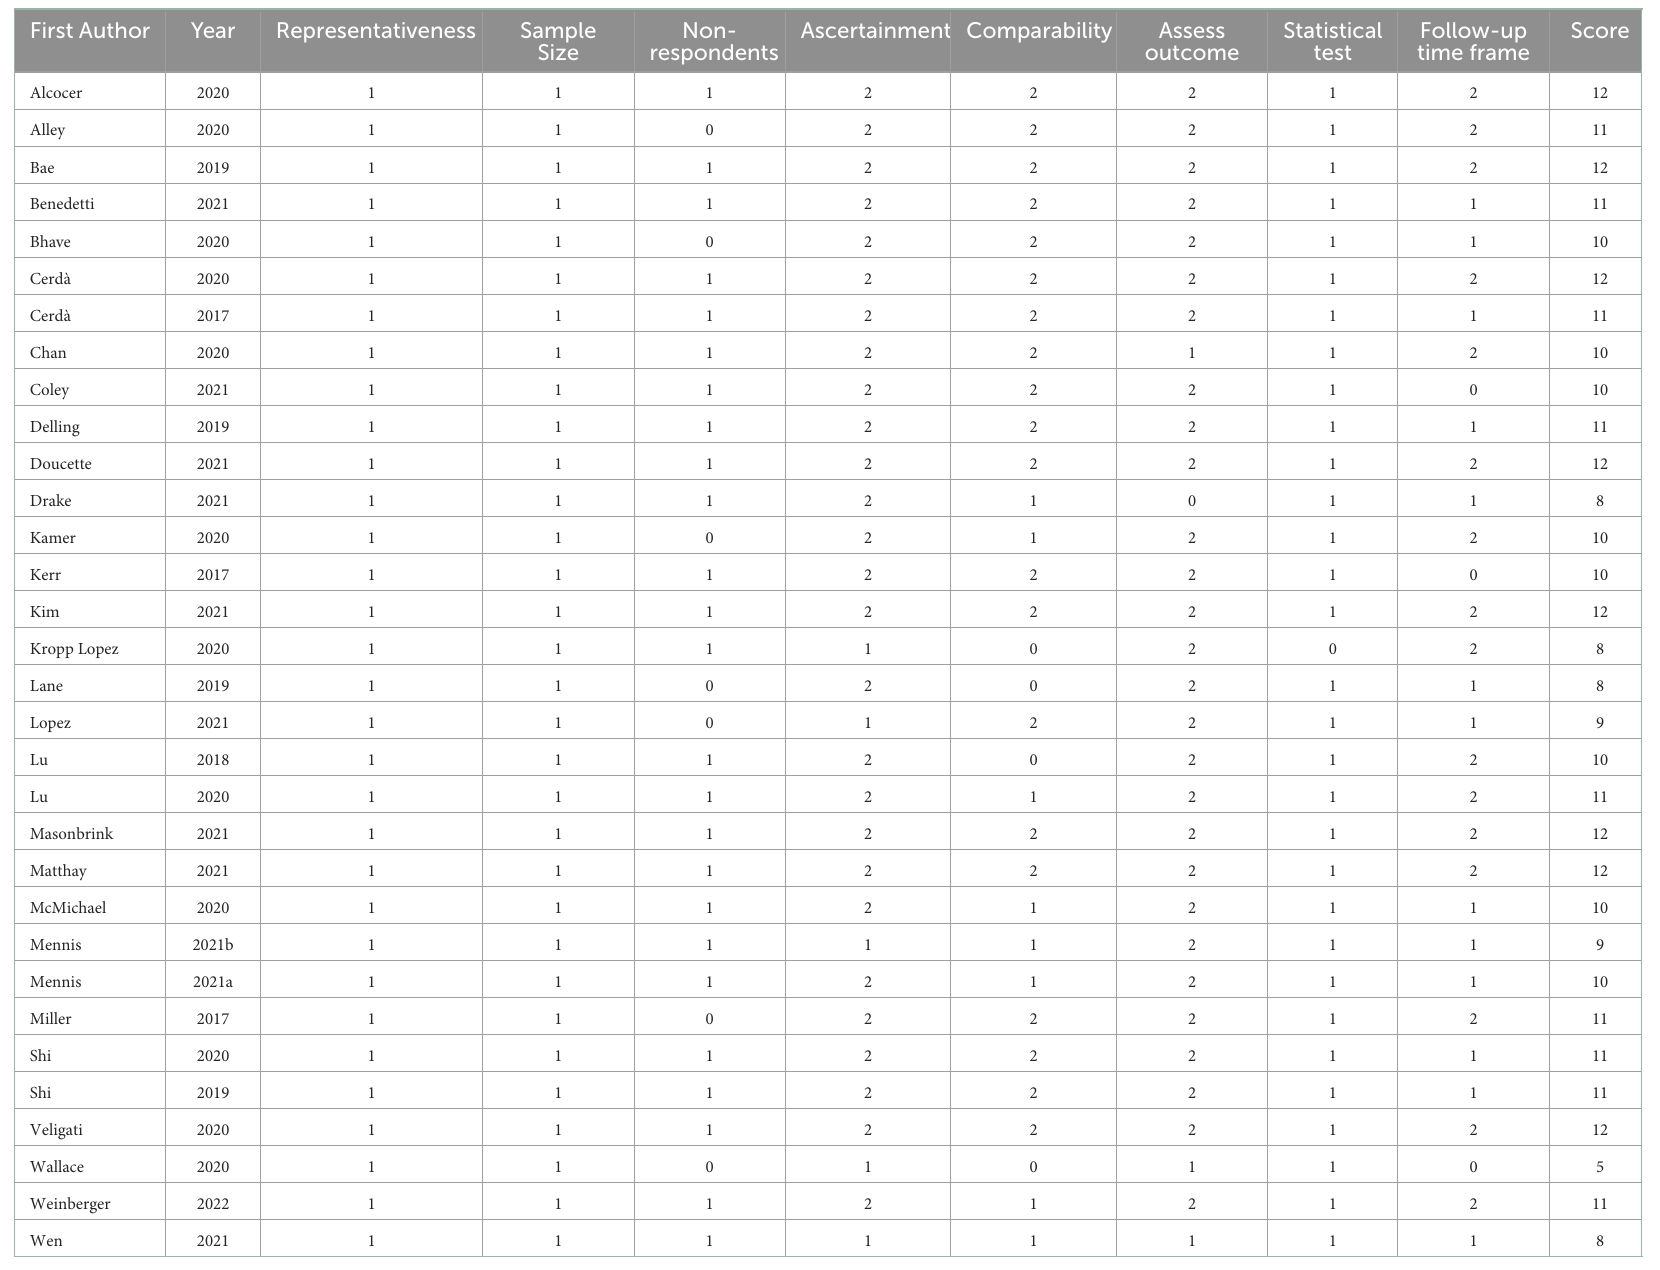
TABLE 2 Bias assessment of longitudinal studies investigating the impact of cannabis legalization public health outcomes used for primary